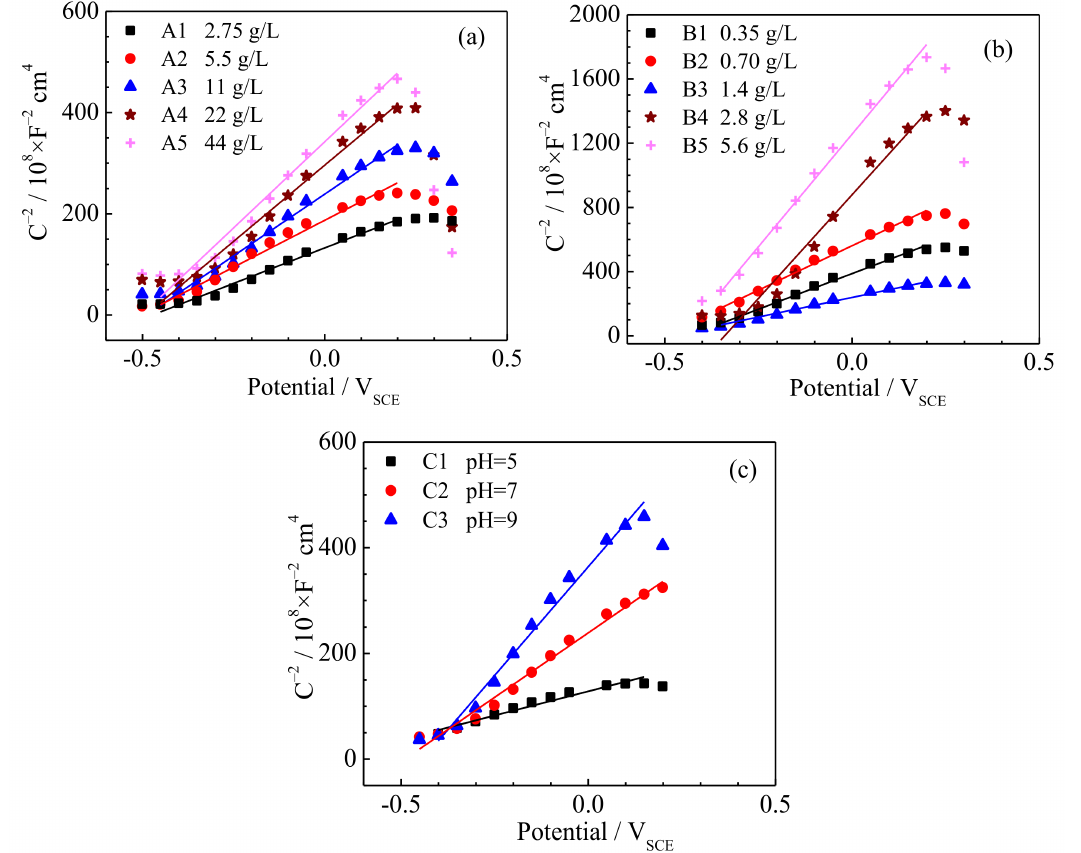
Figure 5. Mott–Schottky plots of the 201 stainless steel in the underground water with different contents of SO 42 − , HCO 3 − , and a different pH, ( a ) A1–A5 solutions with different concentration of SO 4 2 − , ( b ) B1–B5 solutions with different concentration of HCO 3 − , and ( c ) C1–C3 solutions with different pH